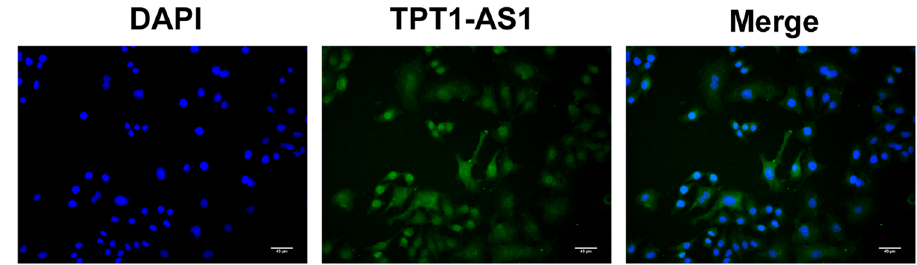
Figure A2: TPT1 - AS1 localization in KYSE510 cells. RNA - FISH revealed that TPT1 - AS1 is mainly colocalized in the cytoplasm of KYSE510